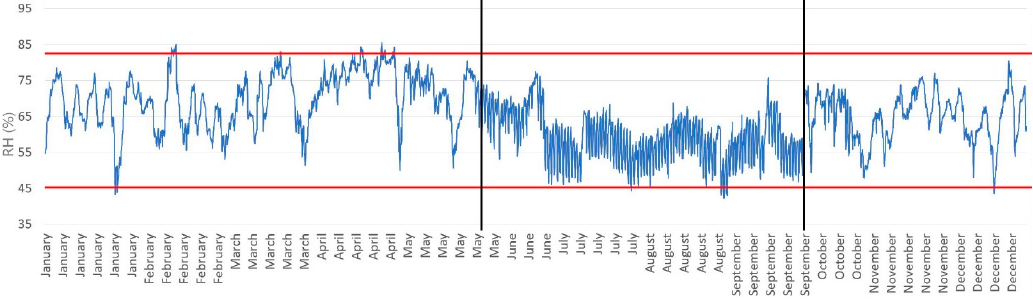
Figure 8. Environmental relative humidity variation in the Quanzhou Bay Exhibition Hall of Song Dynasty shipwreck.